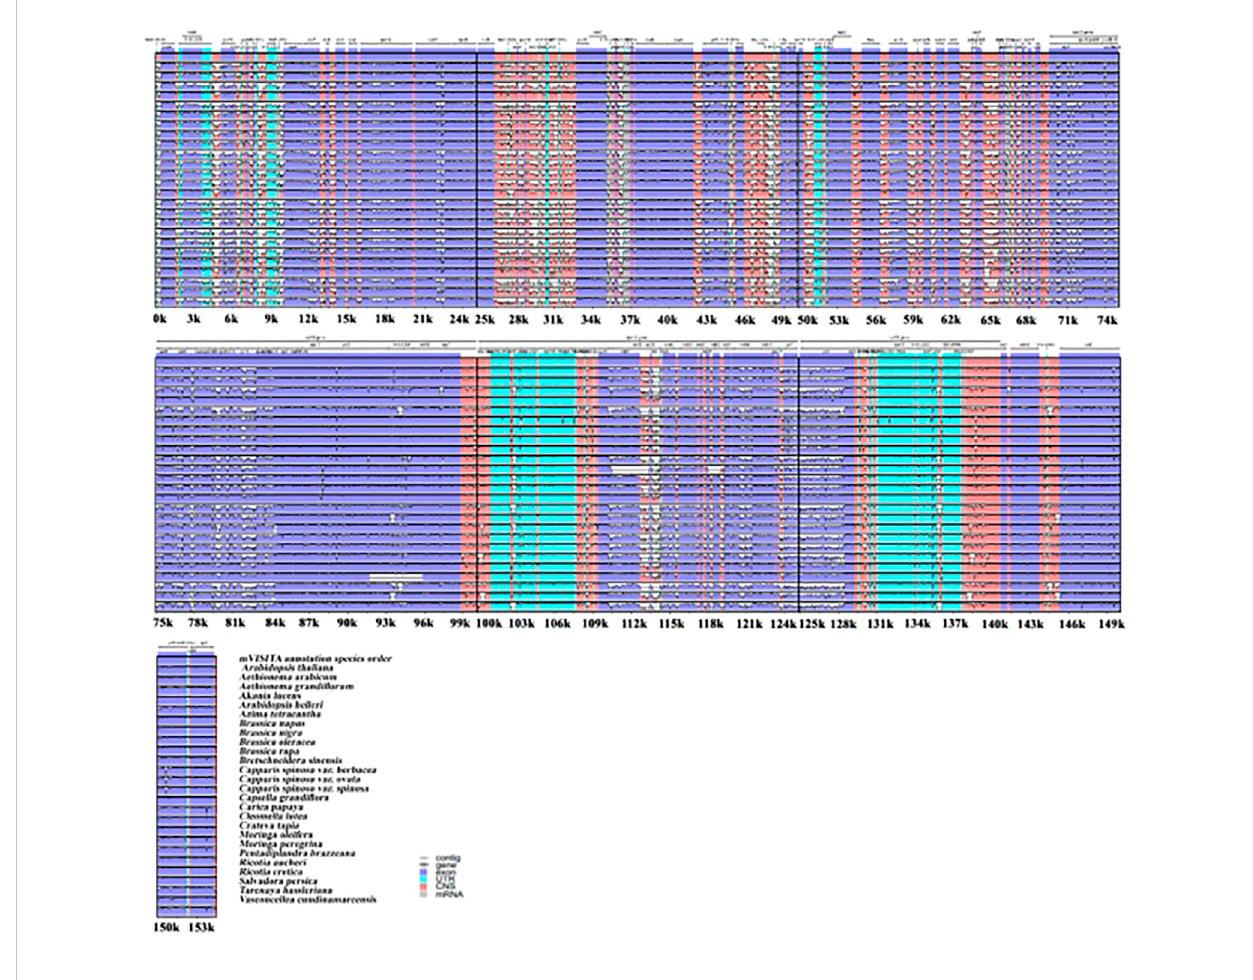
FIGURE 3 Plastomesgenomicvariationsforthe26relativespeicesusingmVISITAsoftware.Theabovegrayaxisobtainedgenes ’ positionandorderinplastome structures and LCS, SSC, and IRs regions.